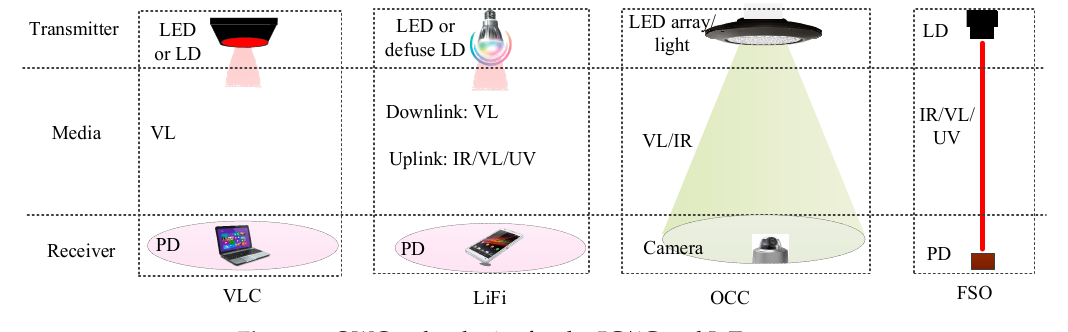
Figure 1. OWC technologies for the 5G / 6G and IoT systems. Table 2. Comparison of the performance metrics in various OWC technologies [2,18,20,24,28,42].